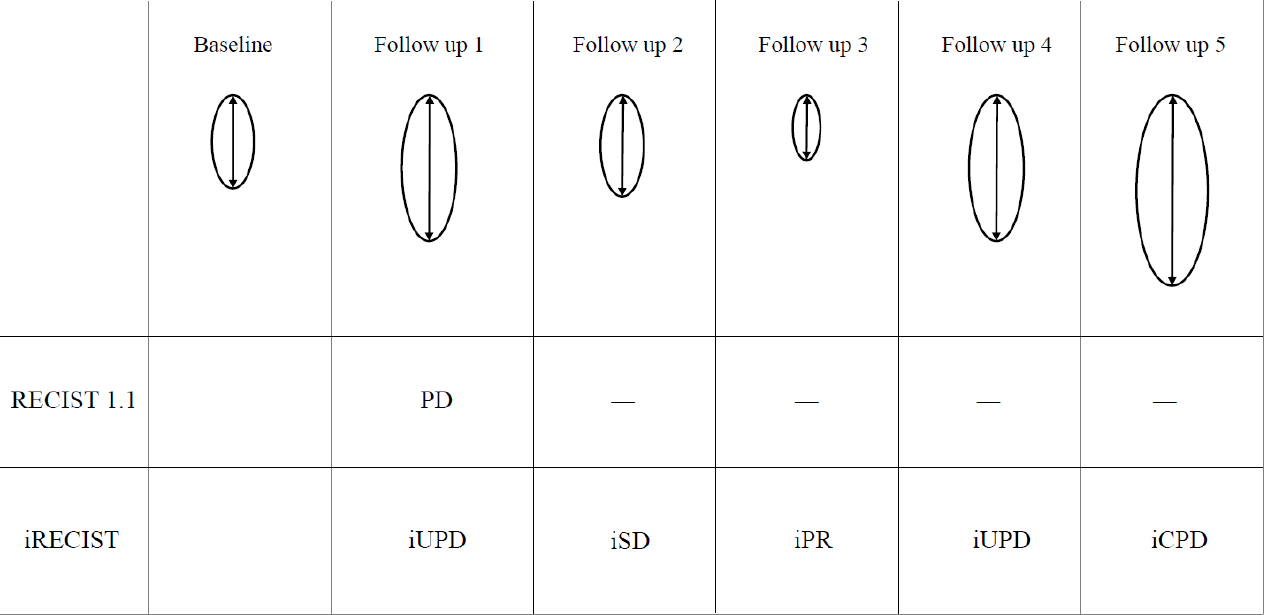
Figure 1. Illustration of a representative case for comparison between the RECIST and iRECIST criteria. Follow-up 1: Increase of ≥ 20% in the longest diameter of target lesion compared to the baseline is judged to be PD in the RECIST 1.1 criteria, and the treatment and tumor assessment are discontinued thereafter. On the other hand, the iRECIST criteria judge the size increase to be representative of iUPD, and the immunotherapy should be continued. Follow-up 2: Increase of the longest diameter compared to the baseline is <20%, which the iRECIST criteria judge to be iSD. The judgement of iUPD at follow-up 1 is reset at this timing. Follow-up 3: Decrease of the longest diameter compared to the baseline is >30%, which the iRECIST criteria judge to be iPR. Follow-up 4: Increase of ≥ 20% in the longest diameter of target lesion compared to the baseline is rejudged to be iUPD by the iRECIST criteria. Follow-up 5: Further increase of >5 mm compared to follow-up 4 is judged to be iCPD, and the immunotherapy should be discontinued at this stage.